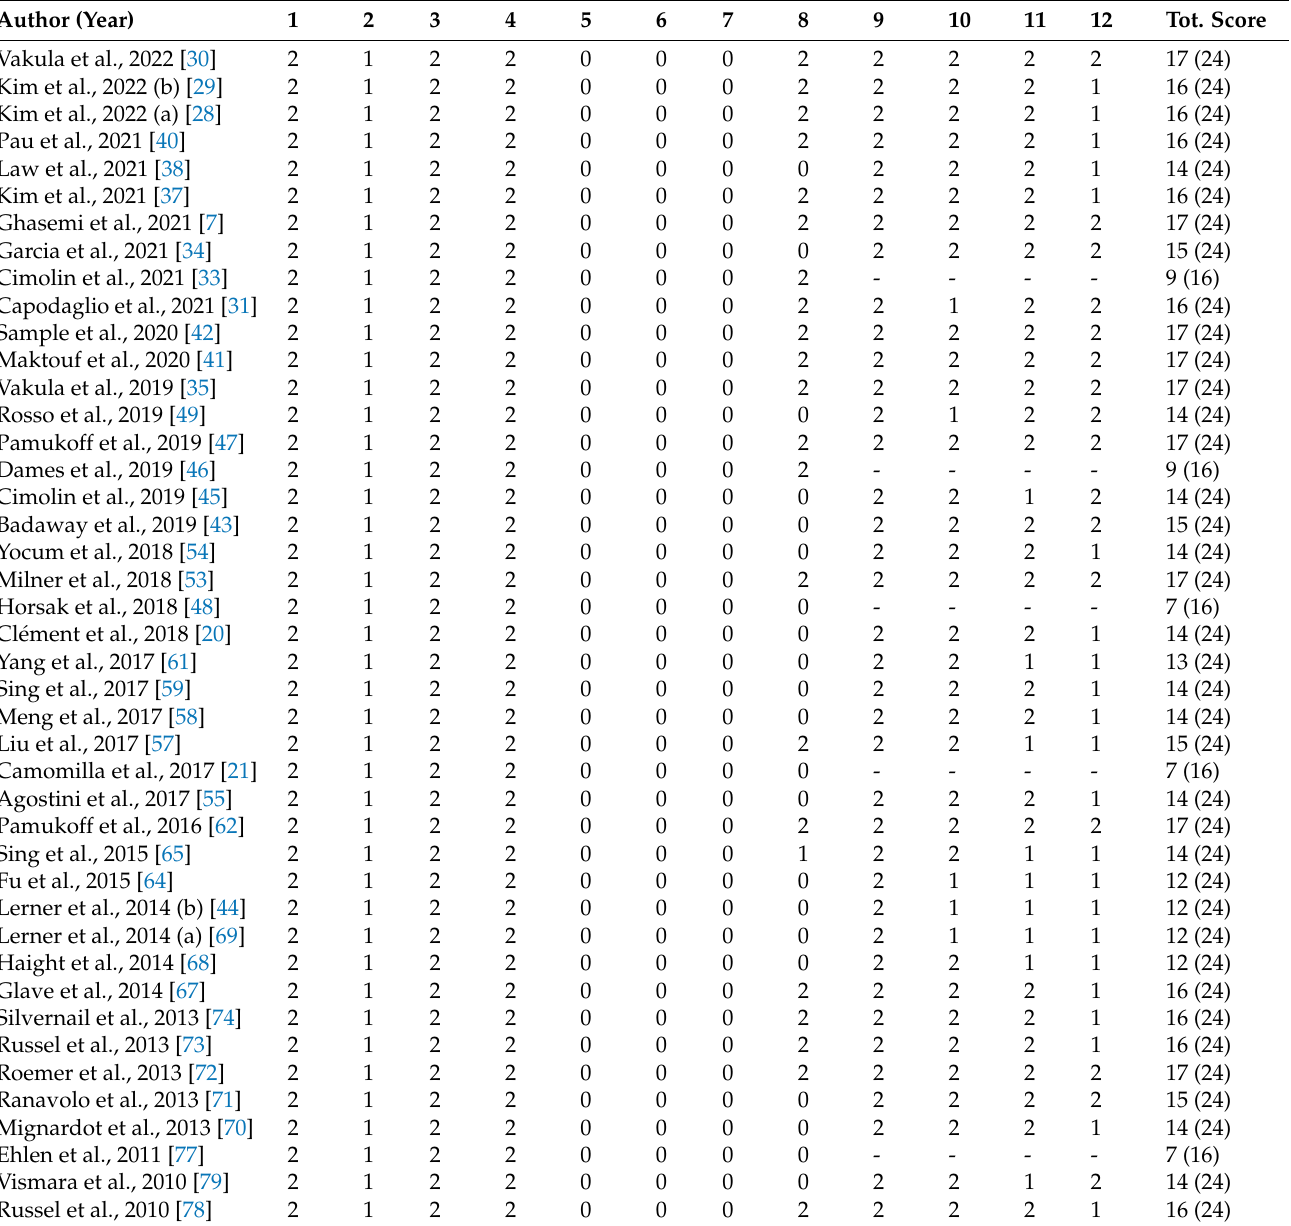
Table 2. List of the included papers assessed using the methodological index (MINORS) tool,